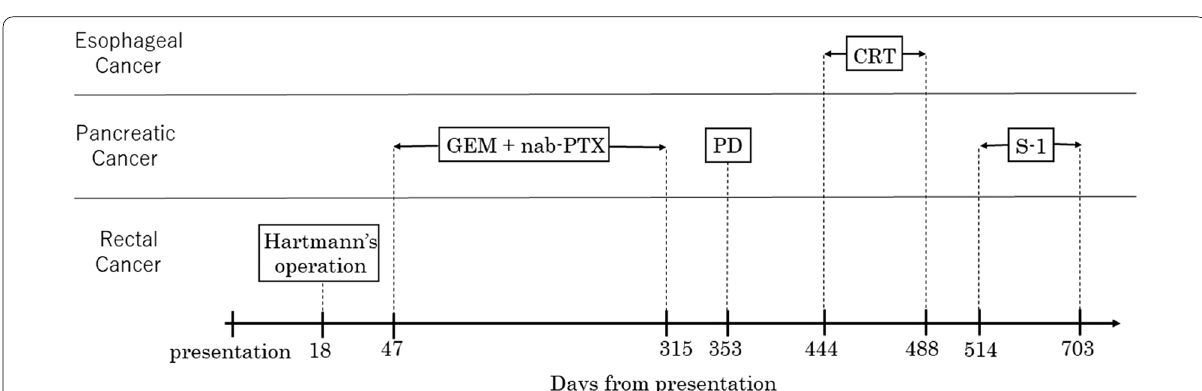
Fig. 3 The outline of whole course of treatment. GEM gemcitabine, nab-PTX nab-paclitaxel, PD pancreatoduodenectomy, CRT